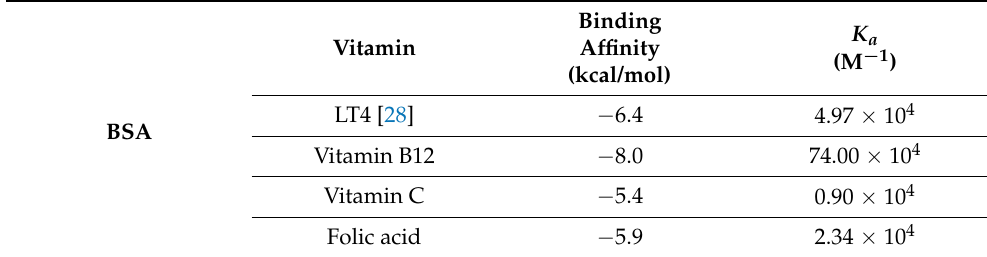
Figure 8. Virtual screening and docking results for the best binding of vitamin C, folic acid, and vitamin B12 to BSA conformation. The driving forces contacts of the interaction are represented by colored symbols as follows: van der Waals ( • ), conventional hydrogen bonds ( • ), and hydrophobic ( • ) forces. Table 3. Molecular docking parameters for the best orientation of LT4 and vitamins at the binding site of